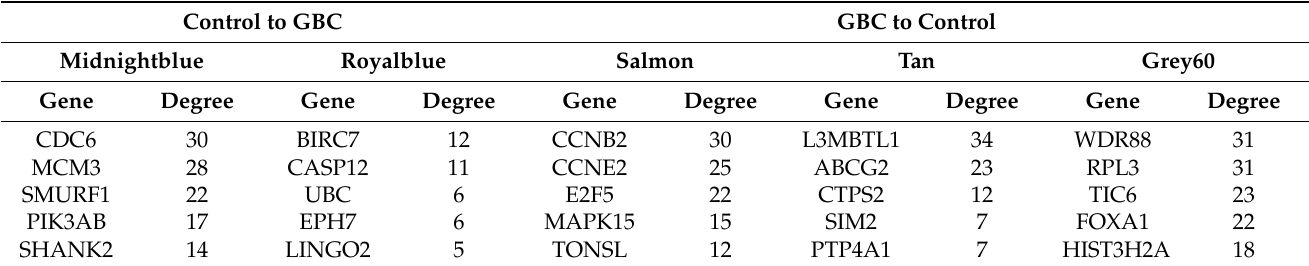
Figure 4. PPI network analysis of non-preserved modules. The PPIs network of the genes identified from the non-preserved modules of control network (mignightblue and royal blue modules) and GBC network (salmon, tan and grey60 modules). The small blue circles represent the proteins and large red node represents the genes in the modules. Table 2. Hub gene identification from non-preserved modules through PPI network analysis.